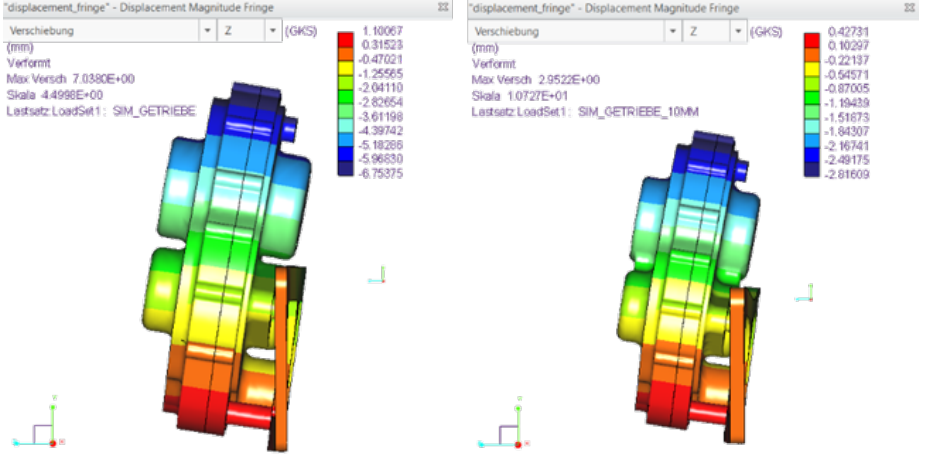
Figure 17. Displacement with the first design ( left ) and the optimized geometry ( right ).